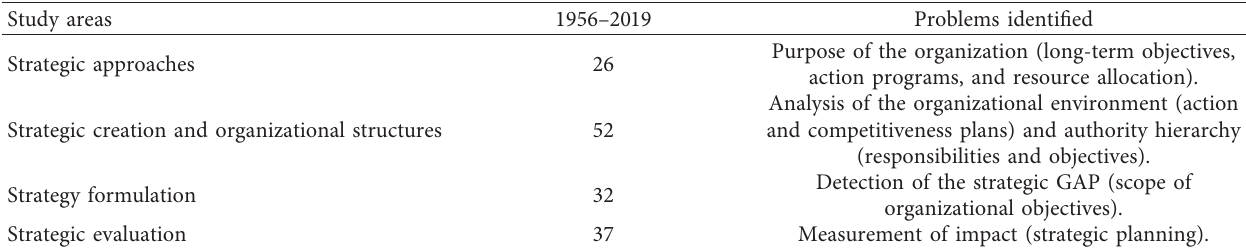
Table 1: Literature review: strategic